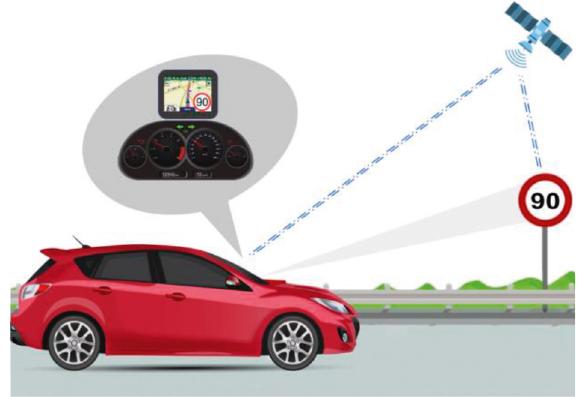
Figure 1: Visual illustration of the ISA